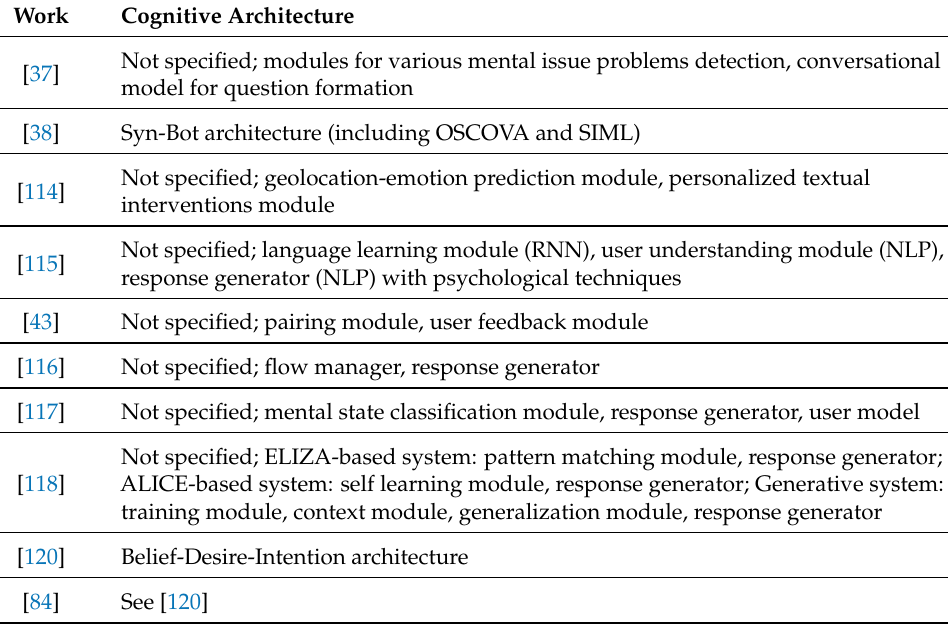
Table 8. Answering RQ7. What is the overarching cognitive architecture used in the